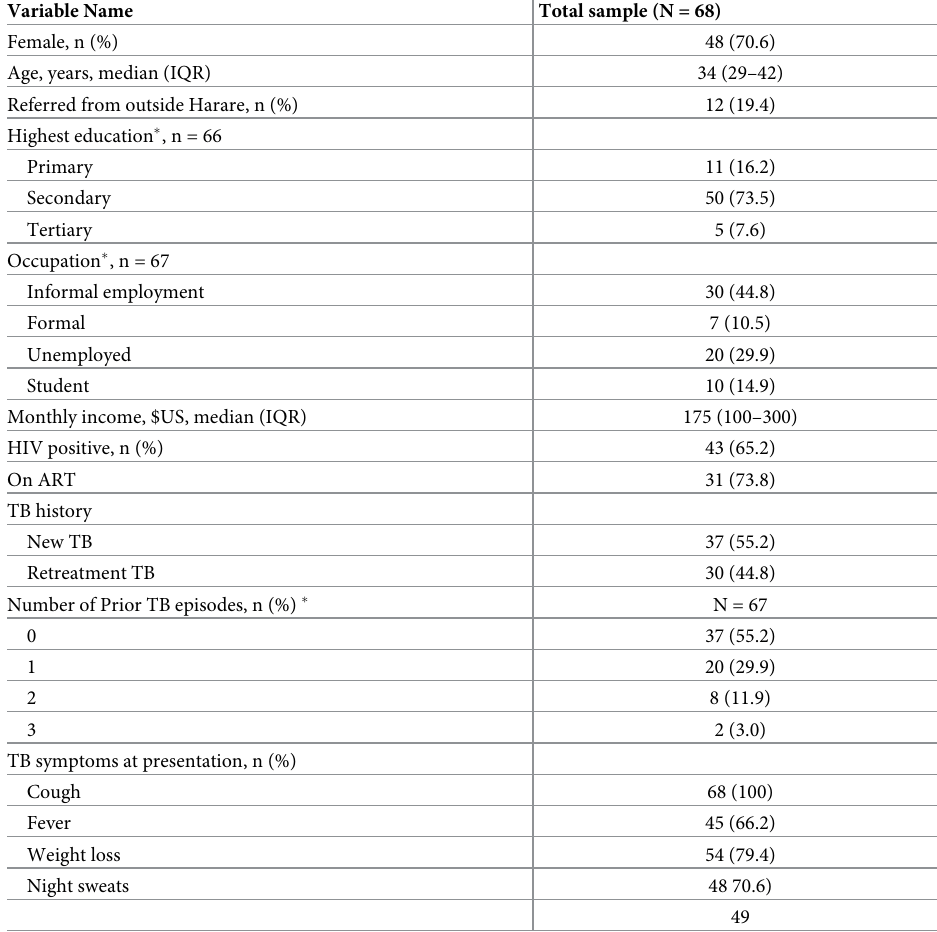
Table 1. Socio-demographic and clinical characteristics of RR-TB patients, Harare,